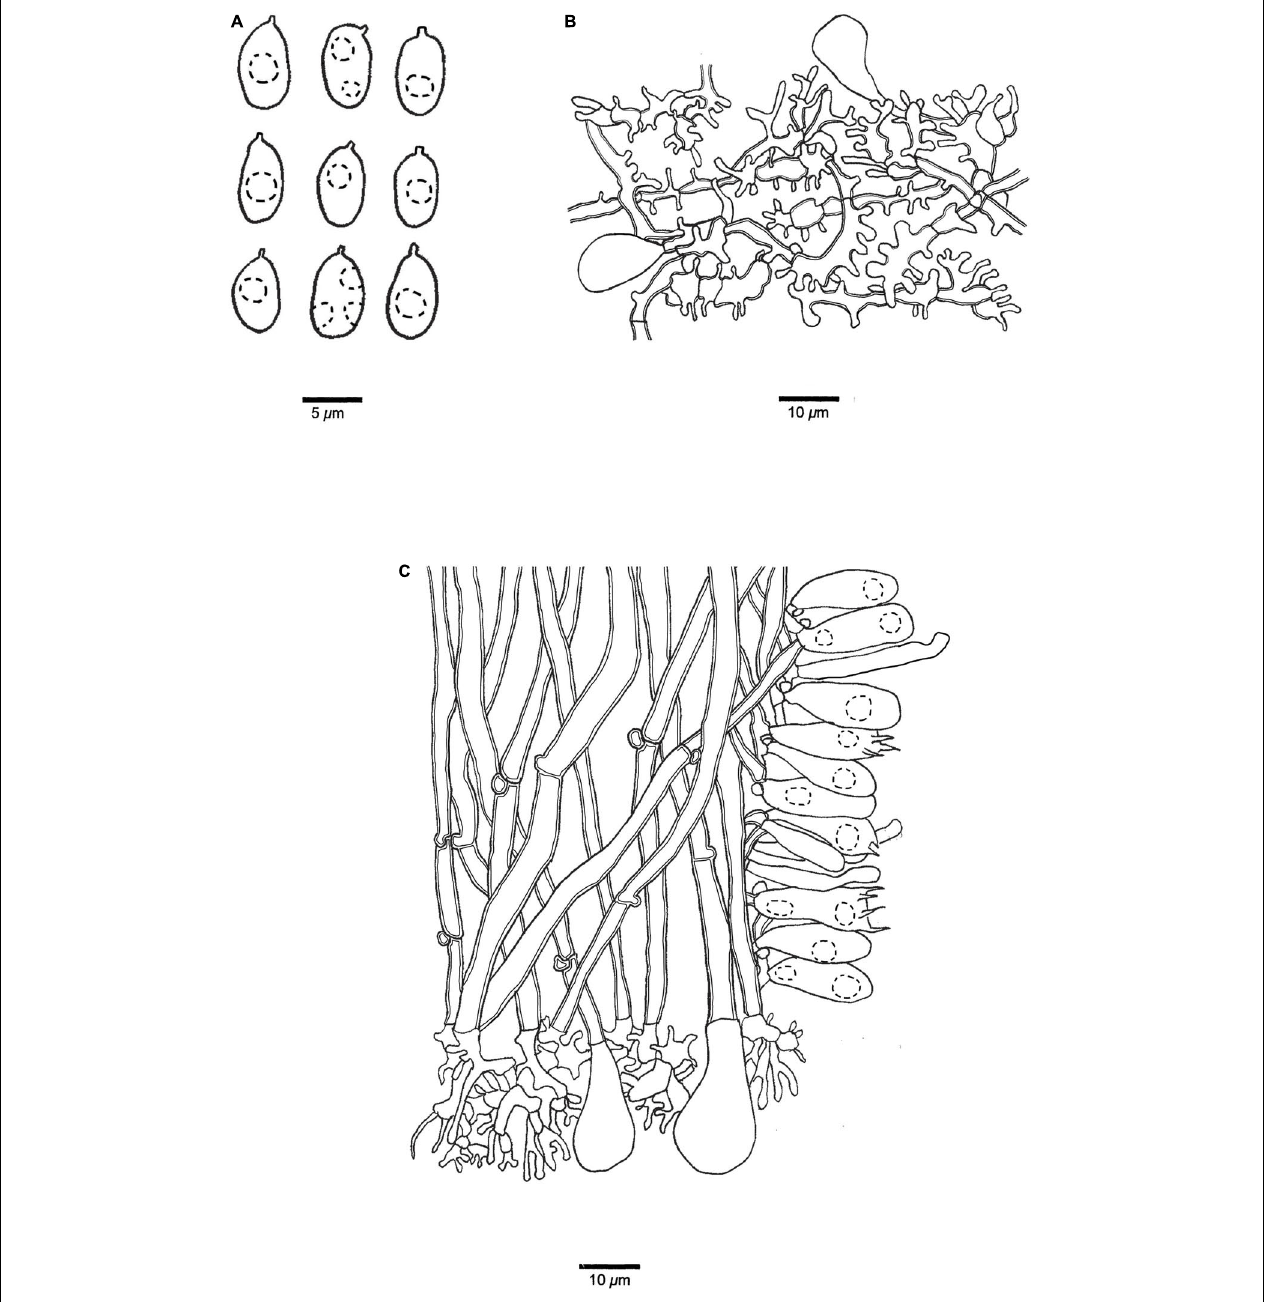
FIGURE 8 | Microscopic structures of Panellus minutissimus (holotype). (A) Basidiospores. (B) Dichophysial hyphae and pileocystidia from pileipellis. (C) A section of tube trama, including pleurocystidia, cheilocystidia, basidia, and basidioles. The dotted circles represent some guttules in basidiospores, basidia or